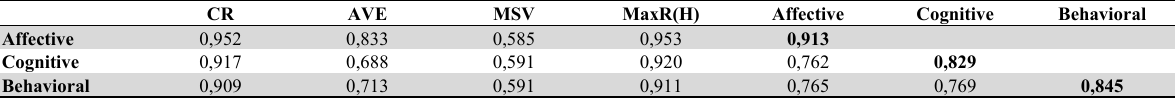
Construct Validity Results of Organizational Cynicism